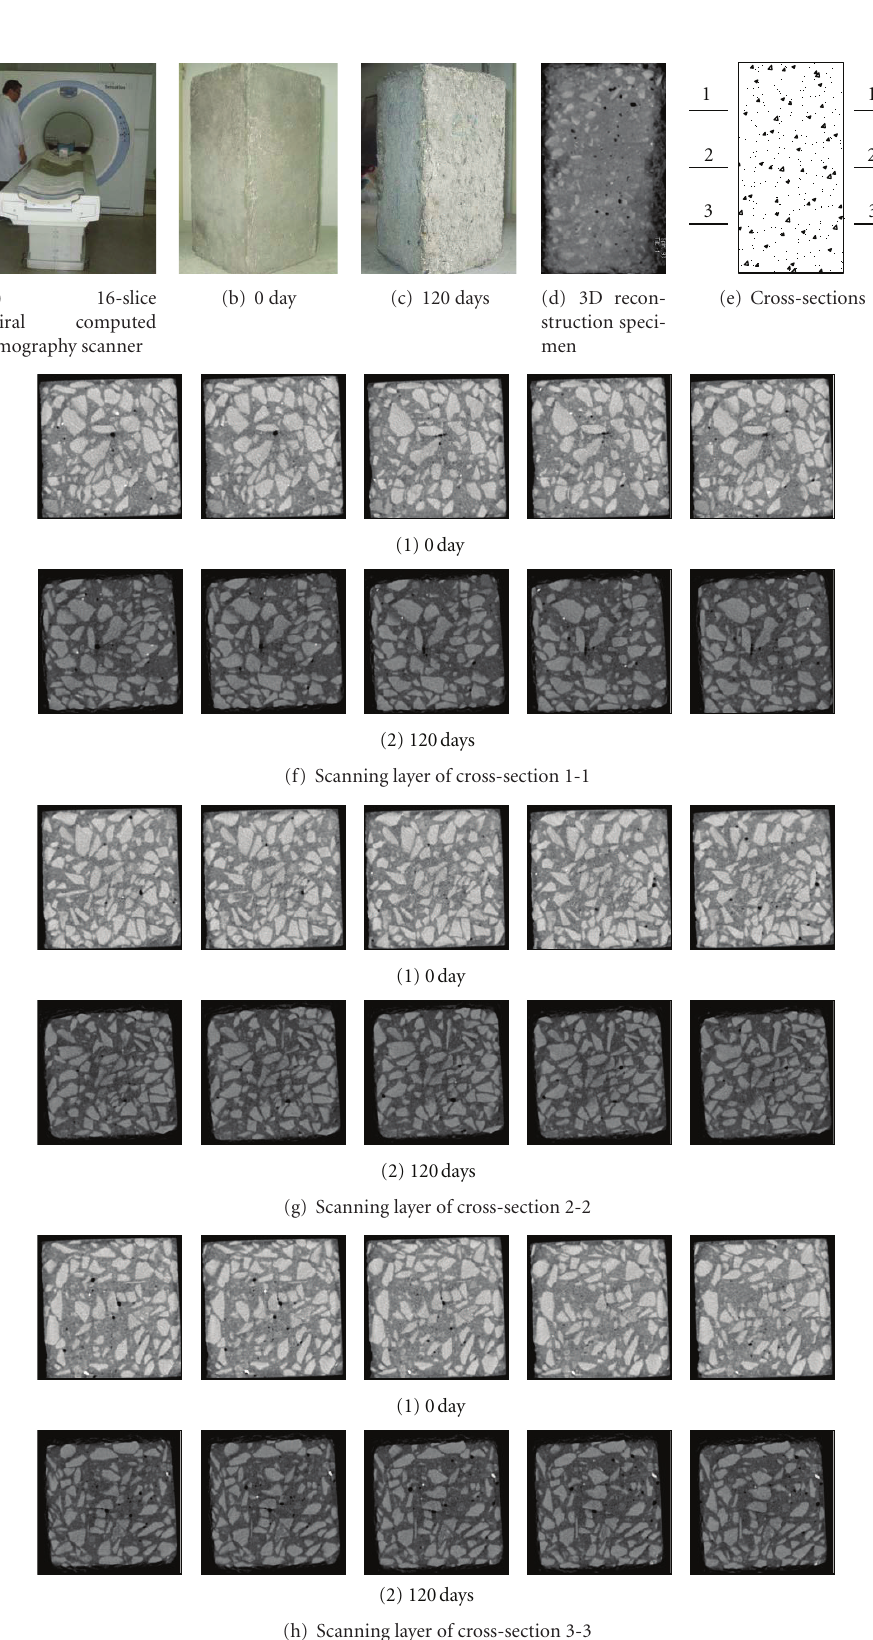
Figure 7: Comparison of CT images of specimen exposed to acid solution for di ff erent